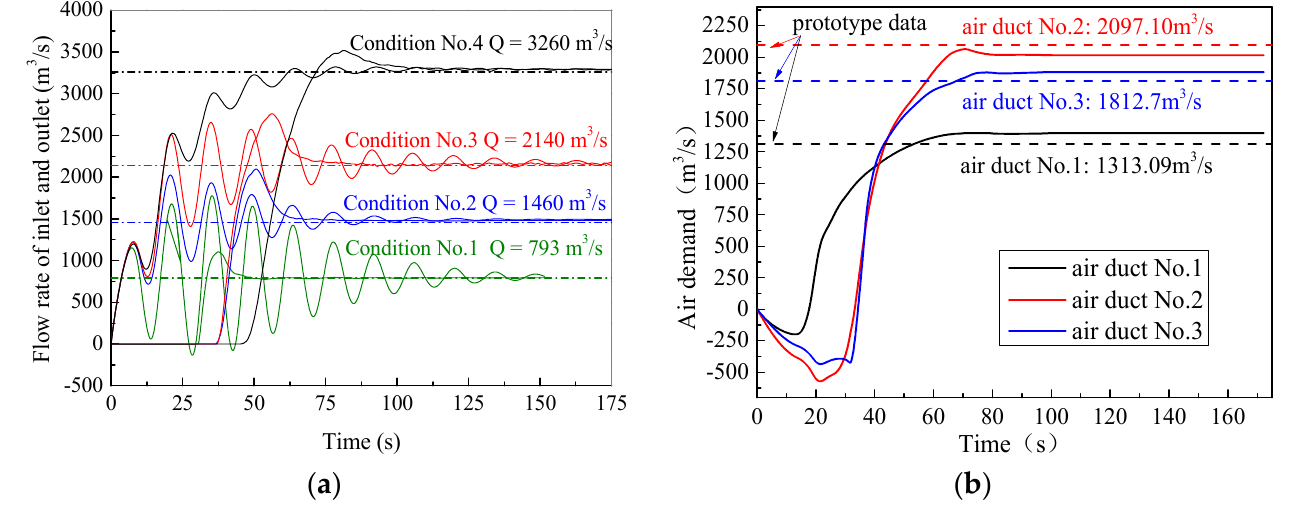
Figure 3. The time independence of documented value: ( a ) flow rate of inlet and outlet; ( b ) air demand.